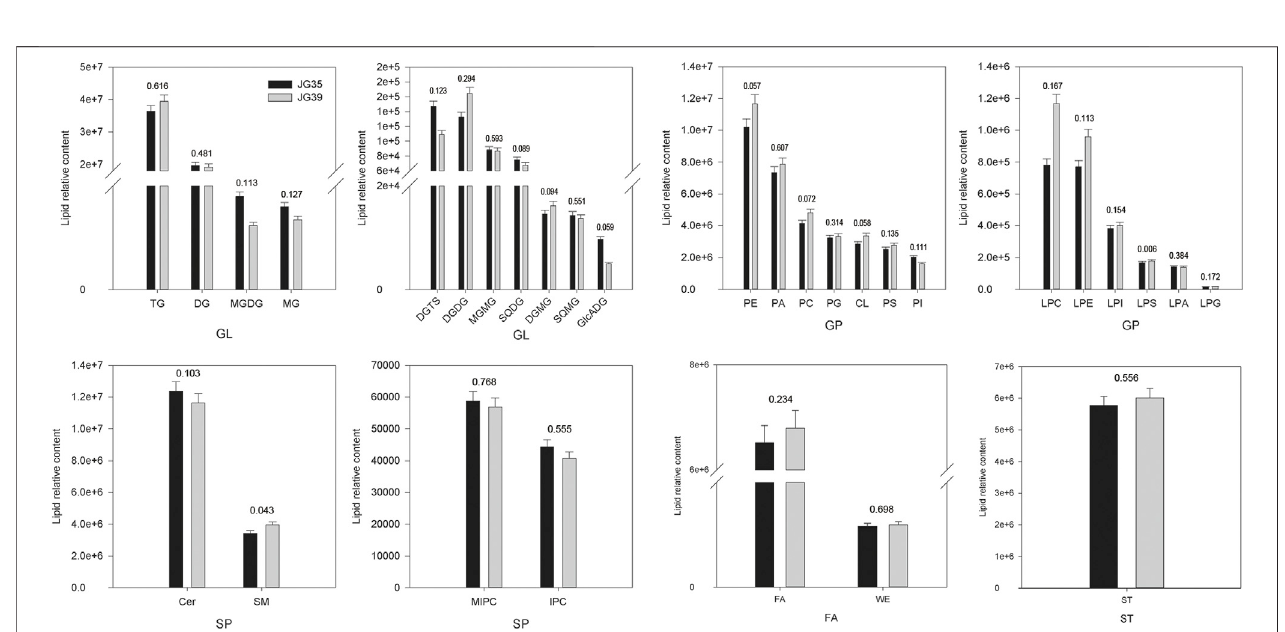
FIGURE 4 | Lipid composition of foxtail